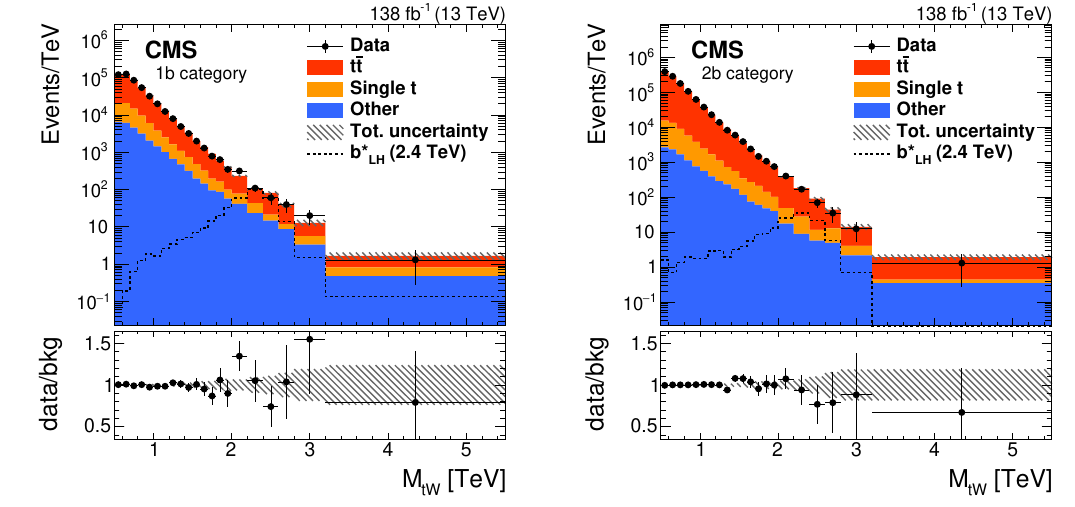
in the 1 b (left) and 2 b (right) categories. The data are shown Figure 2 . Distributions of M tW by filled markers, where the horizontal bars indicate the bin widths. The individual background contributions are given by filled histograms. The expected signal for an LH b ∗ with a mass of = 2 . 4 TeV is shown by a dashed line. The shaded region is the uncertainty in the total m b ∗ background estimate. The lower panels of each figure show the ratio of data to the background estimate, with the total uncertainty in the predicted background displayed as shaded